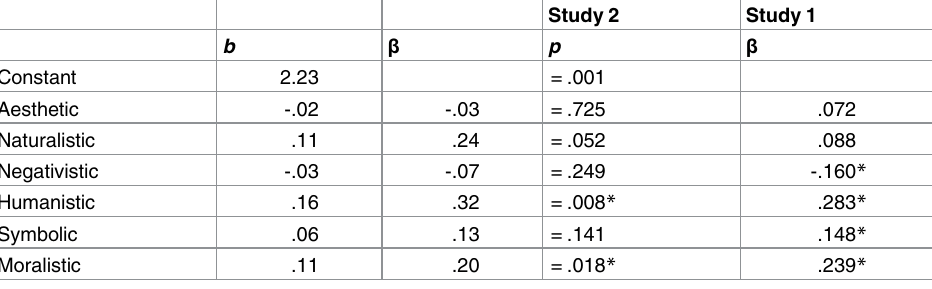
Table 12. Engagement with nature indicators as predictors of nature connectedness (N = 118).